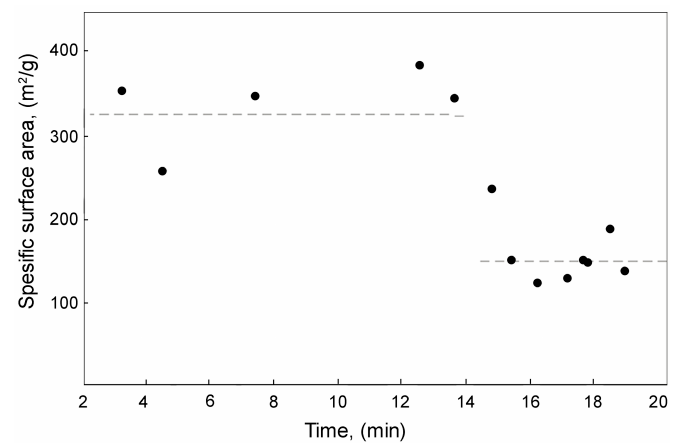
Figure 12. Relation between synthesis time and specific surface area during MSS synthesis of ZrO 2 nanoparticles in water, at 4 MPa reaction